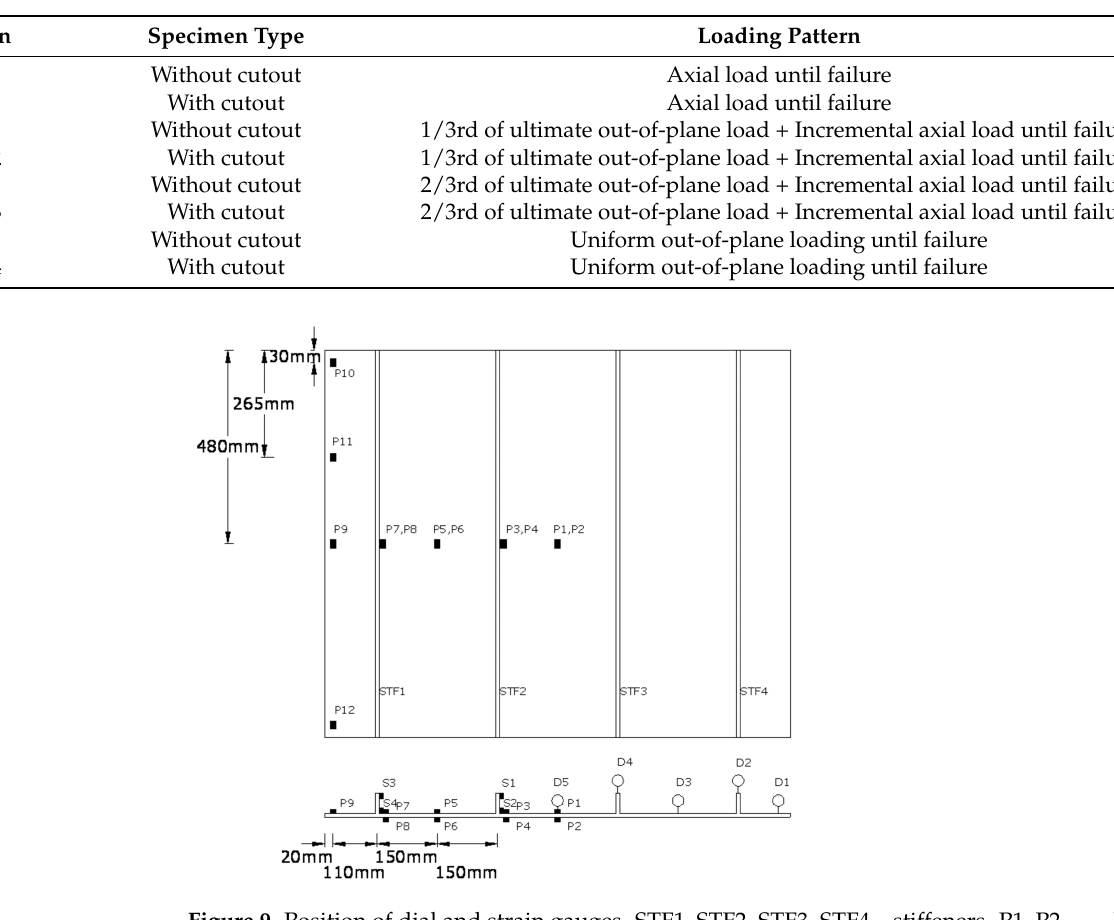
Table 4. Loading pattern of GFRP-stiffened composite.